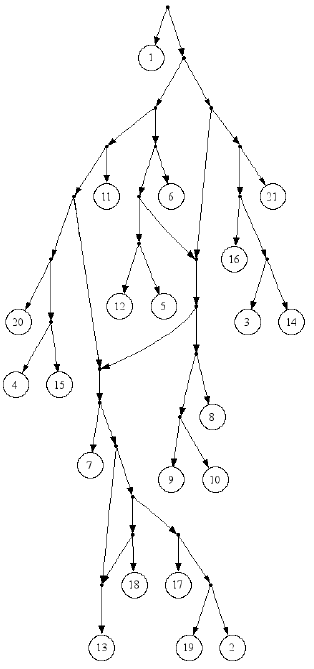
Table 1. The six alternatives of e score